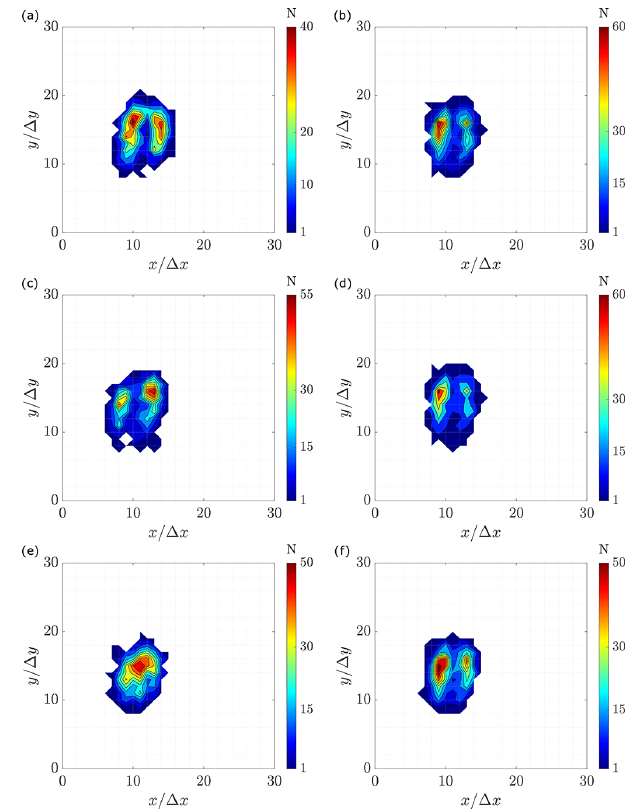
Figure A4. Q -criterion probability contours. (a) Backward differ- ence. (b) Central difference. (c) Forward difference. (d) Richardson extrapolation. (e) Least squares. (f) Circulation